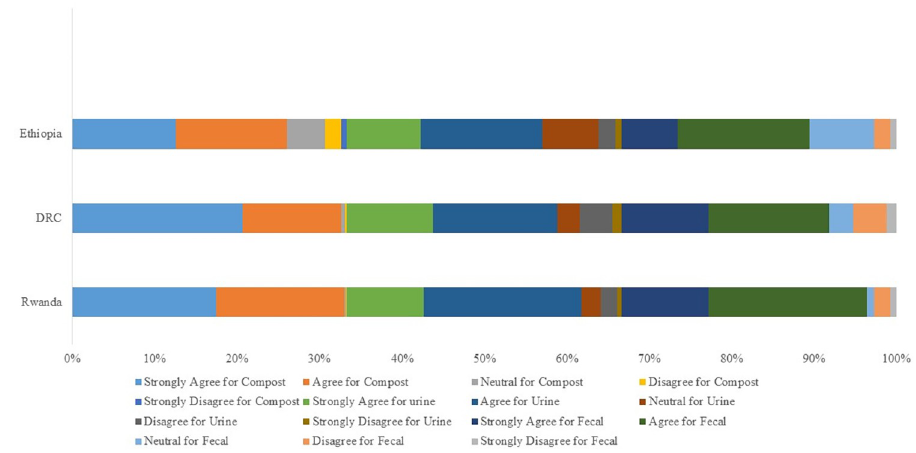
Fig 2. Household opinion on eating foods grown on CBE